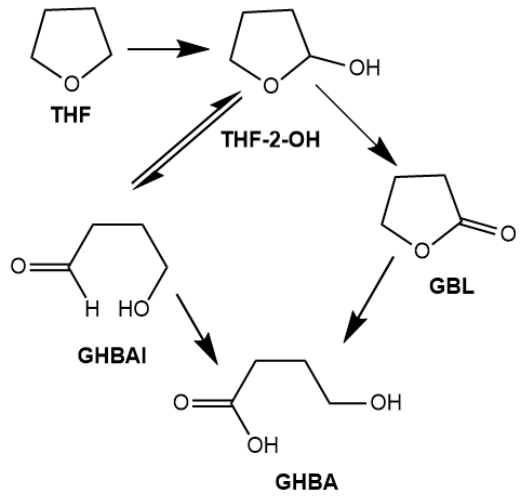
Figure 15. Proposed reaction pathway for THF oxidation over ZFNPs catalyst.